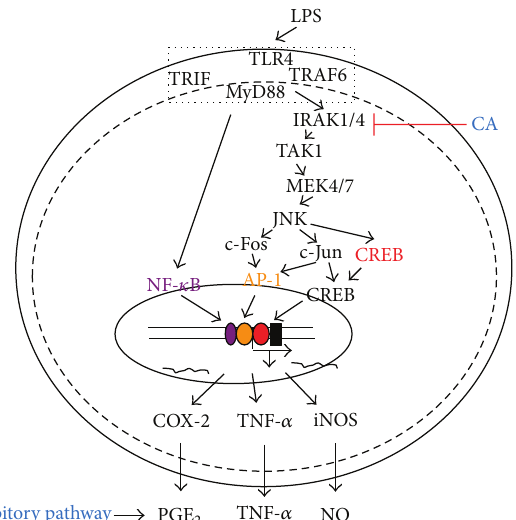
Figure 6: Putative CA-mediated inhibitory pathway of inflamma- tory signaling